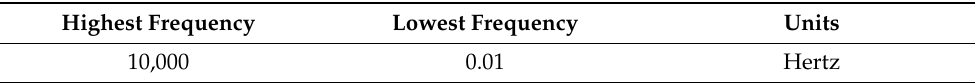
Table 1. Test frequencies.